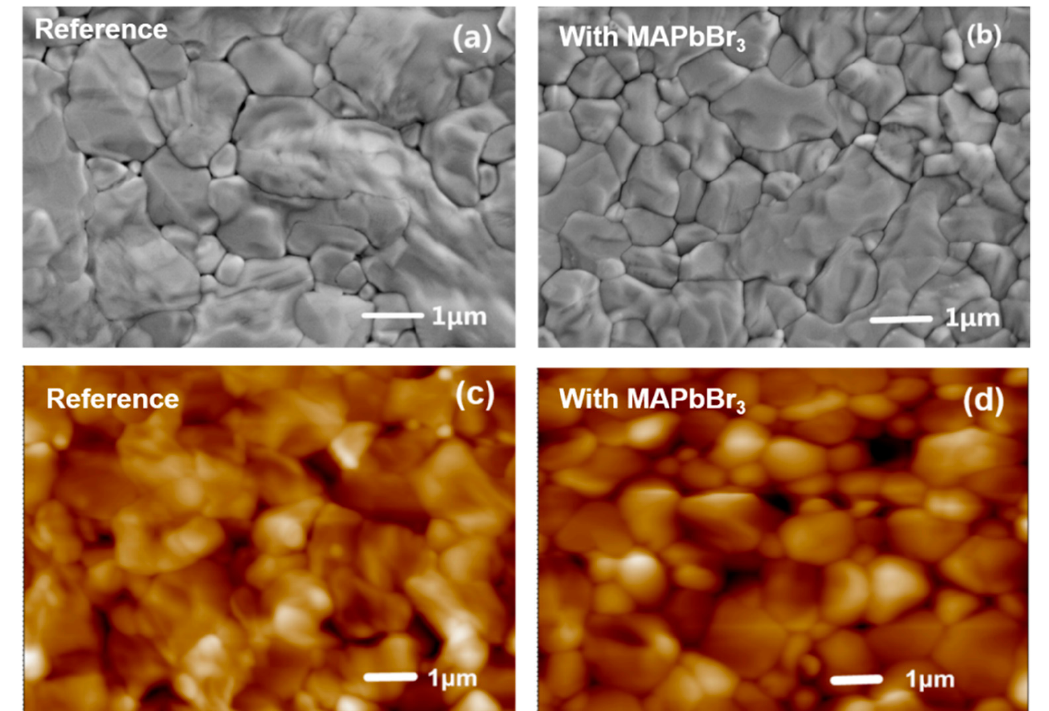
Figure 6. Top-view scanning electron microscopy (SEM) images (upper panel) and atomic force spectroscopy (AFM) images (lower panel) of perovskite films with or without MAPbBr 3 additive: ( a , c ) the undoped perovskite film and ( b , d ) the MAPbBr 3 -doped perovskite film.